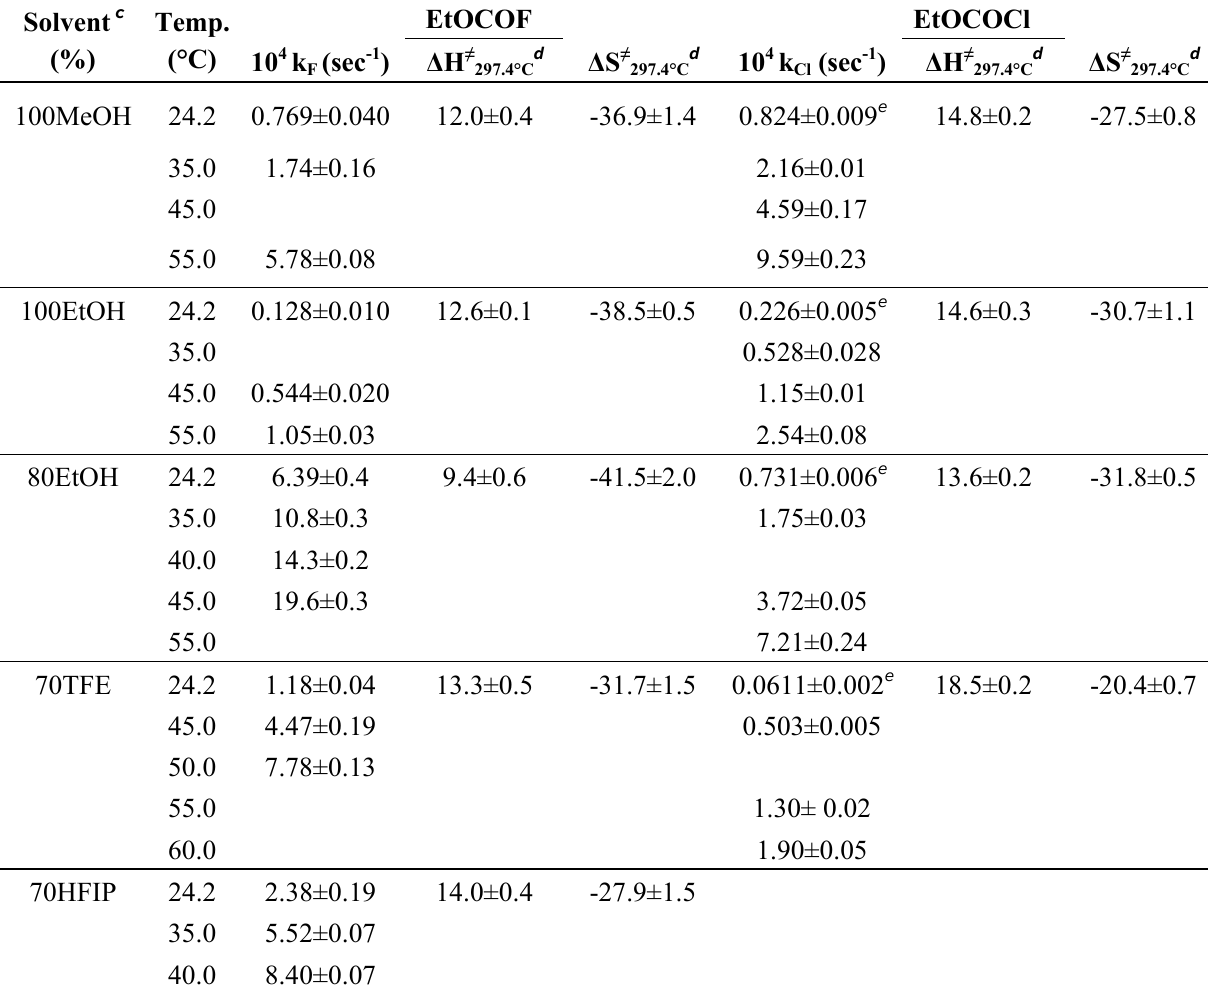
Table 2. Specific rates for solvolysis of ethyl fluoroformate (EtOCOF) a and ethyl chloroformate (EtOCOCl) b at various temperatures, and enthalpies ( Δ H ≠ , kcal mol -1 ) and entropies ( Δ S ≠ , cal mol -1 K -1 ) of